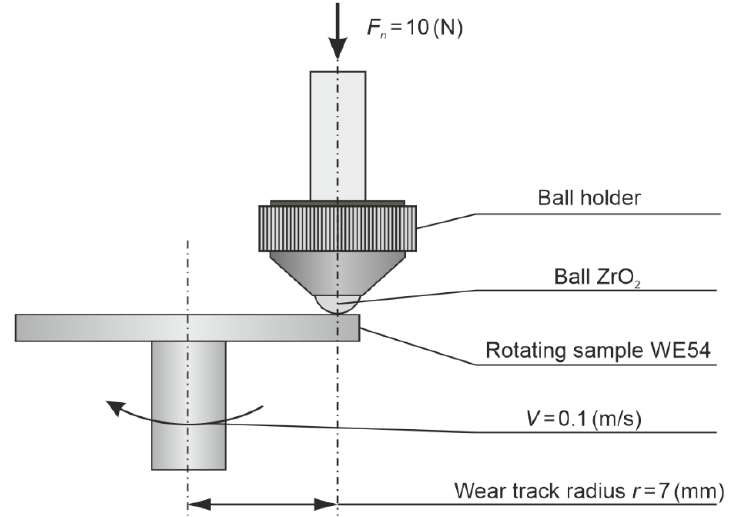
Figure 1. Conditions of tribological tests used for the investigated WE54 alloy.